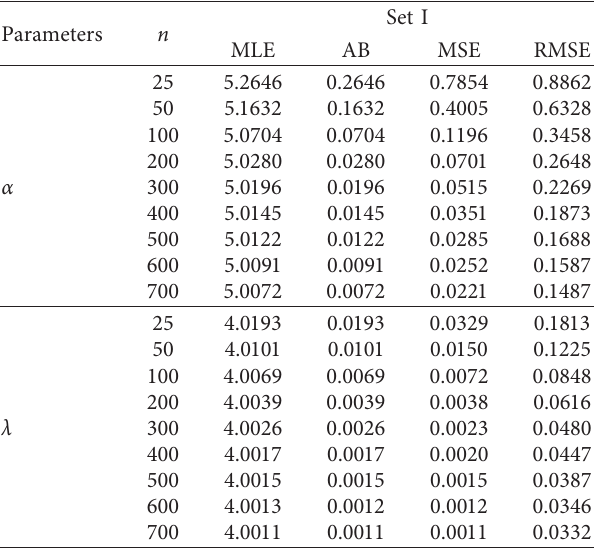
Table 2: Monte Carlo simulation results for the AT-W distribution using Set I values ( α � 5.0 and λ �